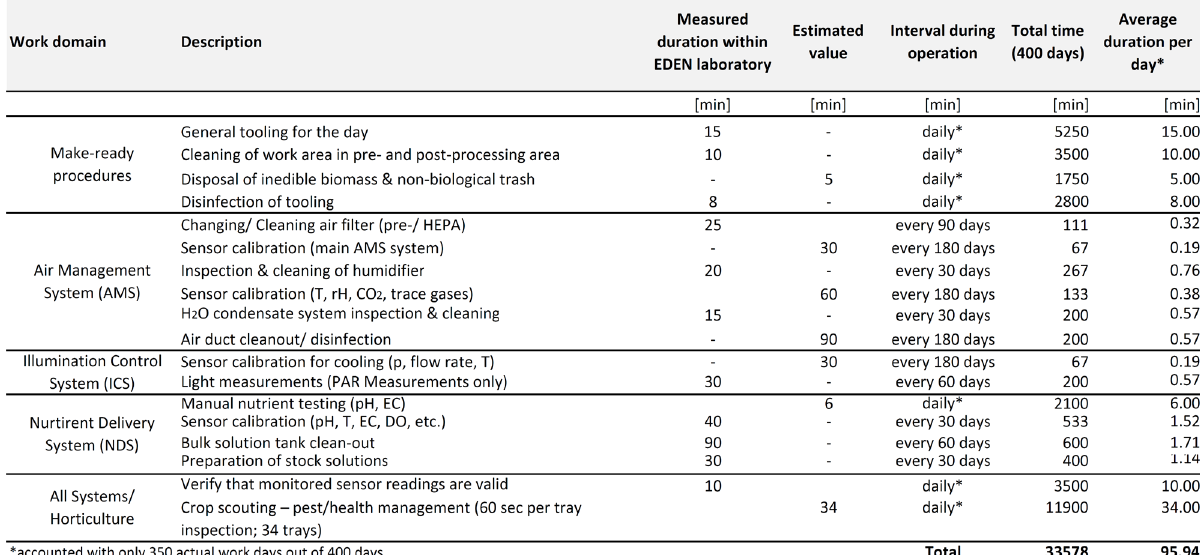
for the three main CEA technologies, ILS, AMS, and NDS. Furthermore, the make-ready times are included as general preparation times for